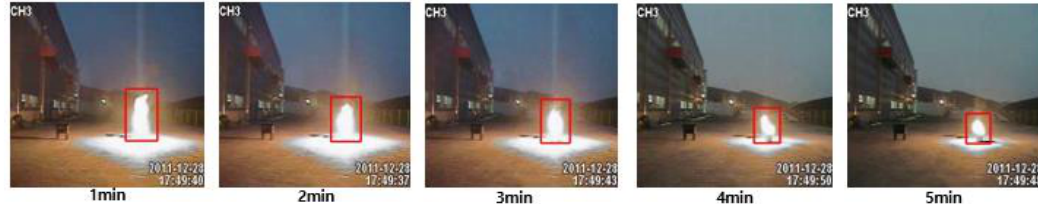
Figure 19. Sample still shots of decreasing flame video clip.